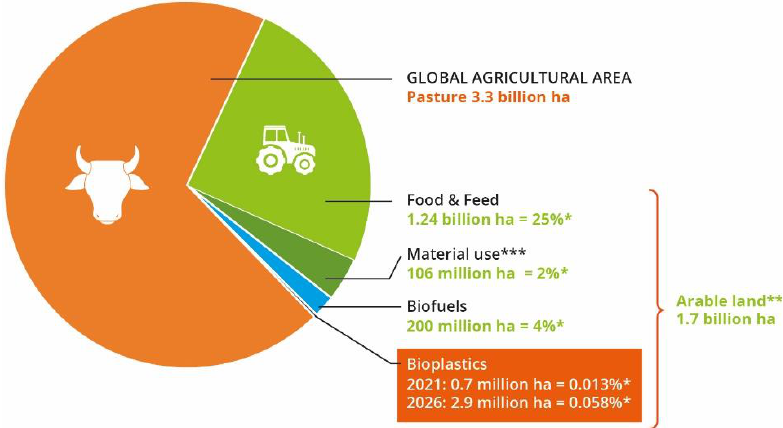
Figure 18. Land use estimation for bioplastics 2021 and 2026. Adapted from European Bioplas- tics, “BIOPLASTICS MARKET DEVELOPMENT UPDATE 2021”, * in relation to global agricul- tural area, ** including approx.. 1% fallow land, *** land-use for bioplastics is part of the 2% material use. https://docs.european-bioplastics.org/publications/market_data/Report_Bioplastics_ Market_Data_2021_short_version.pdf (accessed on 29 December 2022)